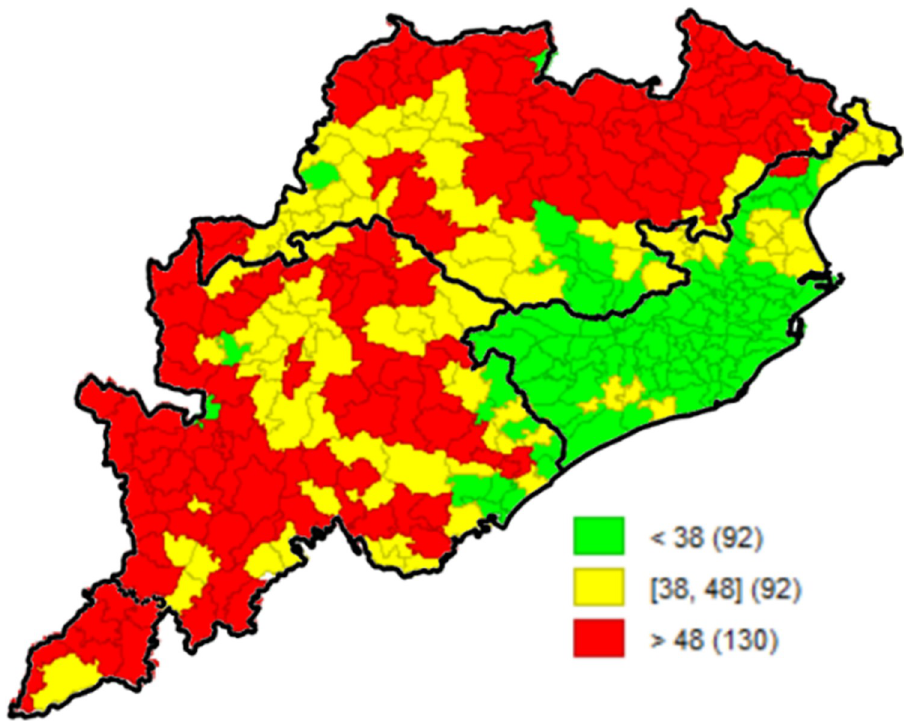
Fig 1. Prevalence of children underweight, block-wise, CCM-II, 2014–15, Odisha, India.